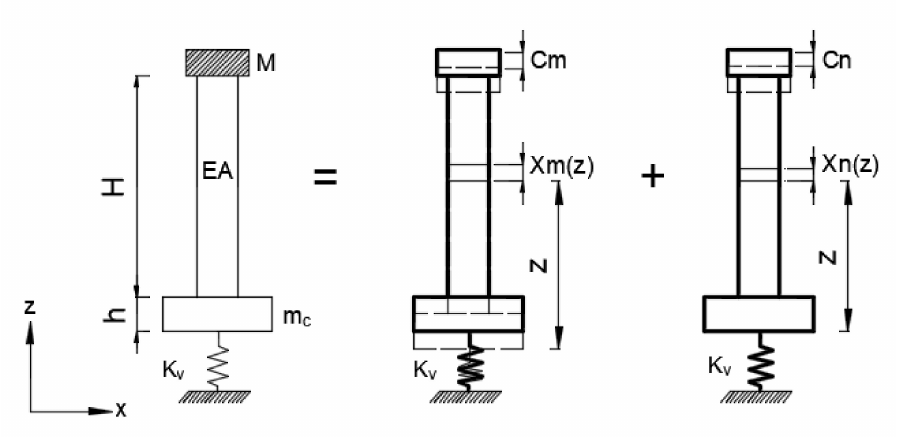
Figure 1. The vertical translation and deformation of the